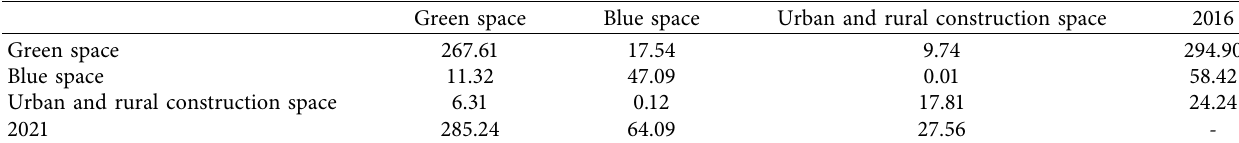
results suggest lower fragmentation of Baiyangdian Wet- land. LSI shows the same trend as NP and PD, indicating simpler landscape shapes and better ecological function of the landscape.